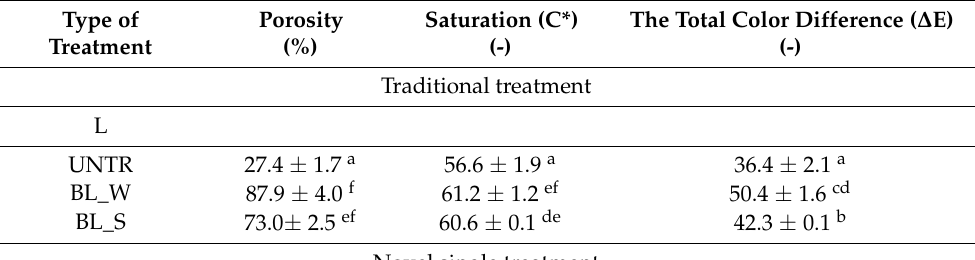
Table 3. Porosity, saturation (C*) and total color difference (in comparison with fresh material) of lyophilized red bell peppers treaded with traditional treatment (BL_W—blanching in water, BL_— steam blanching), novel single treatment (US—sonication for 30 min, PEF_1—pulsed electric field with energy input 1 kJ/kg, PEF_3—pulsed electric field with energy input 3 kJ/kg) or novel hybrid treatment (PEF+US, US+PEF), preceded by shock freezing (L) and vacuum freezing (L_VF). Data are presented as a mean from 2 (for porosity) and 6 (for color parameters) repetitions with error bars as a standard deviation